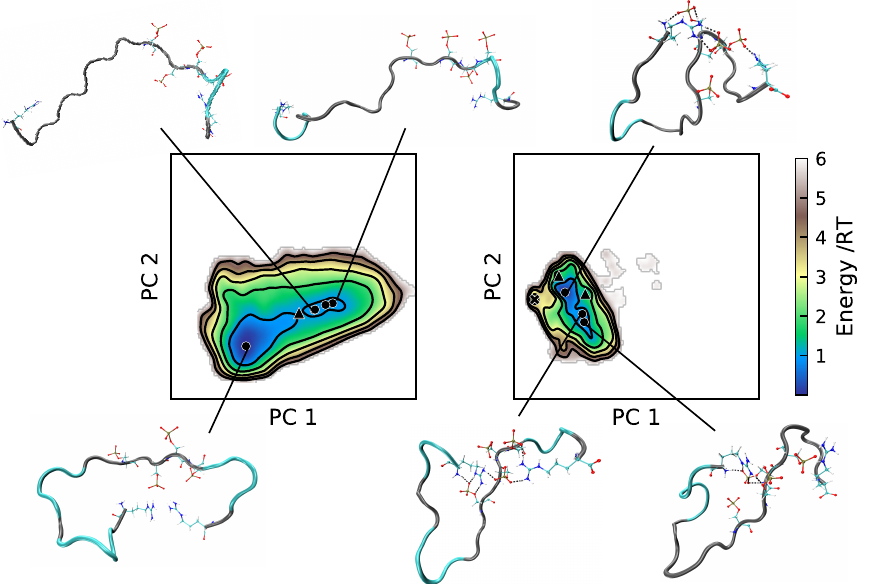
Figure 7. Energy landscapes and conformations in selected minima of bCPP. ( Left ) A99; ( right ) C36. The energy landscapes are constructed using the first two components from principal component analysis, using the same basis set for both force fields, such that they are directly comparable. Contour lines are drawn for integer energy levels in the interval 1 ≤ RT ≤ 5, and the minimum of each basin is represented by a marker: (cid:108) : energy ≤ 1RT, (cid:115) : ≤ 2RT, (cid:54) : ≤ 3RT. In the conformations, the phosphorylated and positively charged residues are shown explicitly. Dashed black lines represent hydrogen bonds. The peptide conformations are color-coded according to the secondary structure determination in VMD, where silver is irregular (coil) and cyan is turns. The N-terminus of each conformation is the leftmost